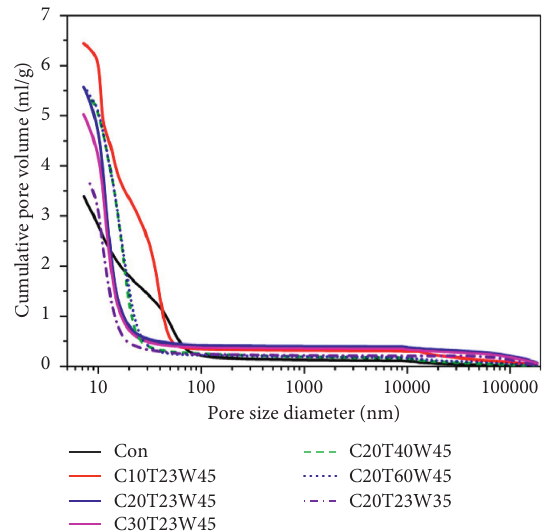
Figure 9: Cumulative pore sizes of representative 28d